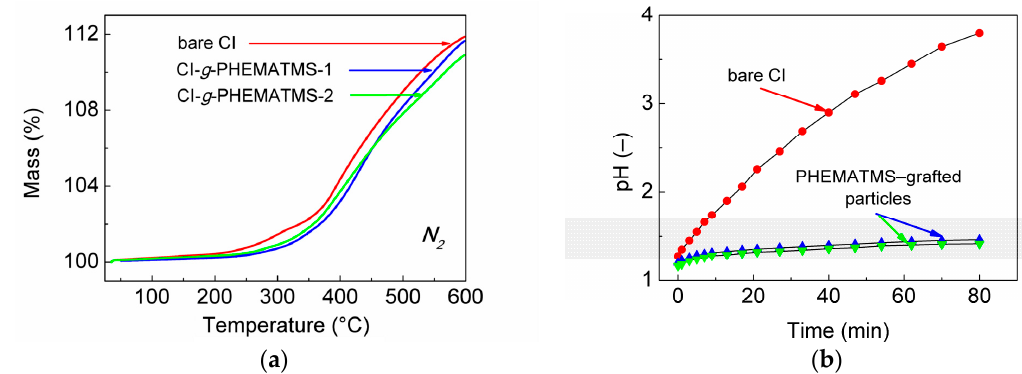
Figure 5. Representations of ( a ) TGA curves, and ( b ) resistance to acidic conditions of bare CI particles, and their PHEMATMS − grafted analogues.